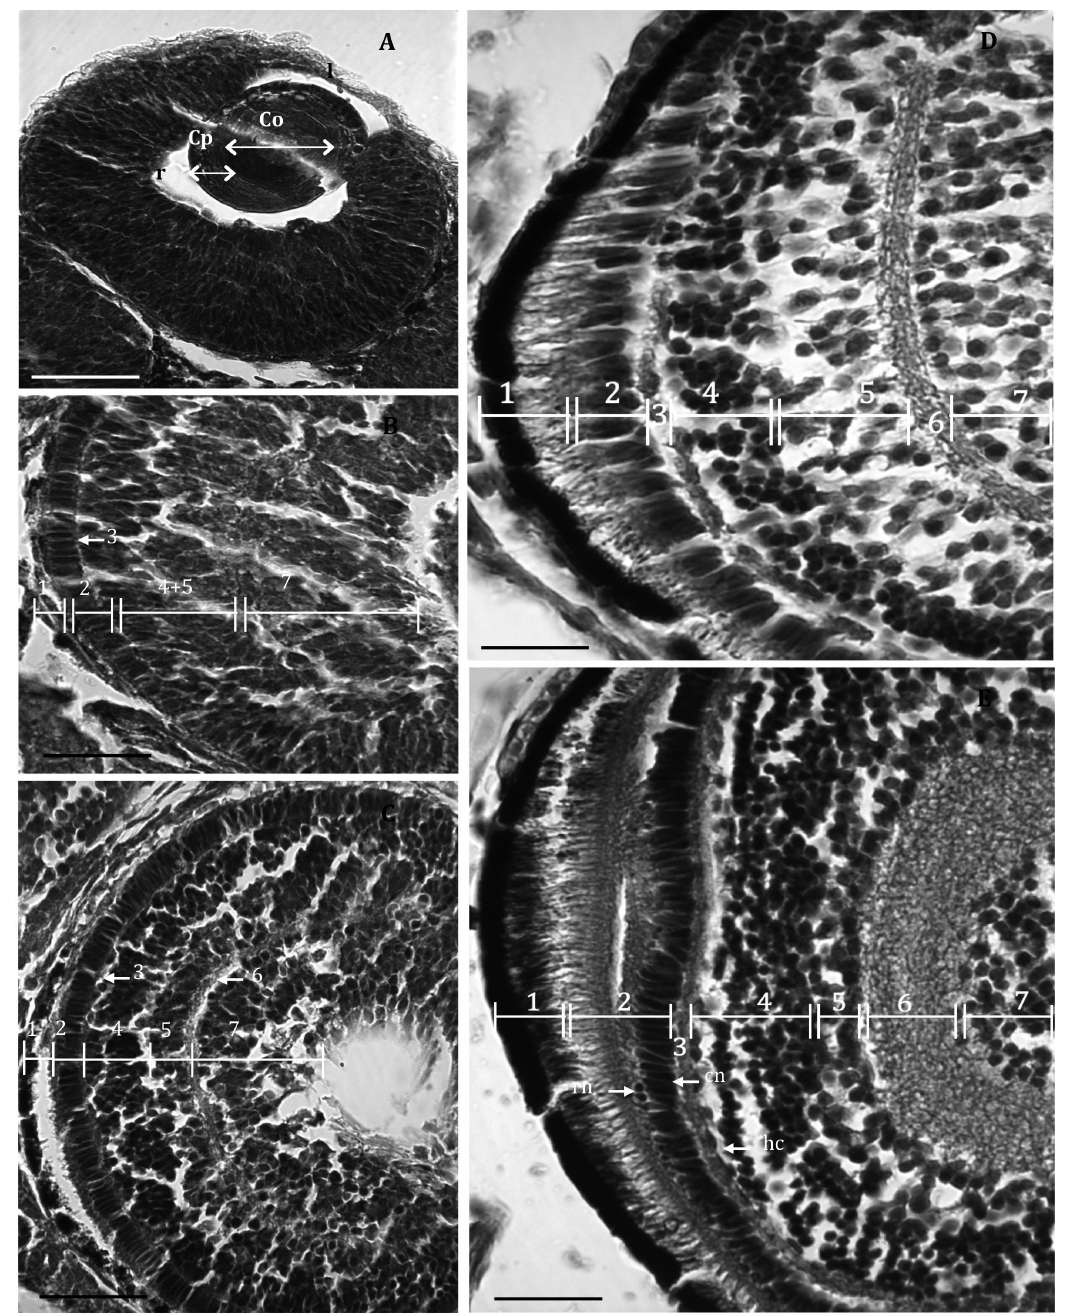
Fig . 3. – Histological development of the retina in hake larvae during endo-exotrophic phase: A) hake larvae at 1 dph showing lens composed of a outer part or capsule and an inner core region. A developing retina composed of undifferentiated cells was clearly distinguished. Scale bar: 50 µm; B) larvae at 2 dph showing different retinal layers: pigmented epithelium (1), neuroretina composed of three radially arranged layers, the outer nuclear layer (2), the inner nuclear layer (4+5), and the ganglion cell layer (7). Between (2) and (4+5) a developing outer plexiform layer (3) was distinguished. Scale bar: 20 µm; C) on day 4 hake larvae showed a developing retina: the choroidal melanocytes layer (1) followed by the photoreceptor layer (2) and an inner nuclear layer which two substrata, the bipolar (4) and amacrine (5) cell layers and a ganglion cell layer (7). Between the (5) and (7), an incipient inner plexiform layer (6) had developed. Scale bar: 20 µm; D) larvae at 6 dph showing a considerable thickening of the neuroretina (2 to 7) and of the pigmented epithelium (1). Scale bar: 20 µm; E) by 9 dph hake larvae showing a full developed retina with a thick and dark eyecup (1) due to numerous melanin granules in the pigment epithelium of the sclera. Following the pigmented layer, photoreceptor layer with two cell types, cones and rod precursor cells, could be detected. The inner nuclear layer made of three substrata, the horizontal, bipolar (4) and amacrine (5) cell layers were also detected. Between the amacrine and ganglion cell, a prominent inner plexiform layer could be distinguished. Scale bar: 20 µm (1: choroidal melanocytes, 2: photoreceptor; 3: outer plexiform; 4: bipolar cells; 5: amacrine cells; 6: inner plexiform; 7: ganglion cells; cn: cone nucleus; Co: core; Cp: capsule; hc: horizontal cells; l: lens; r: retina; rn: rod